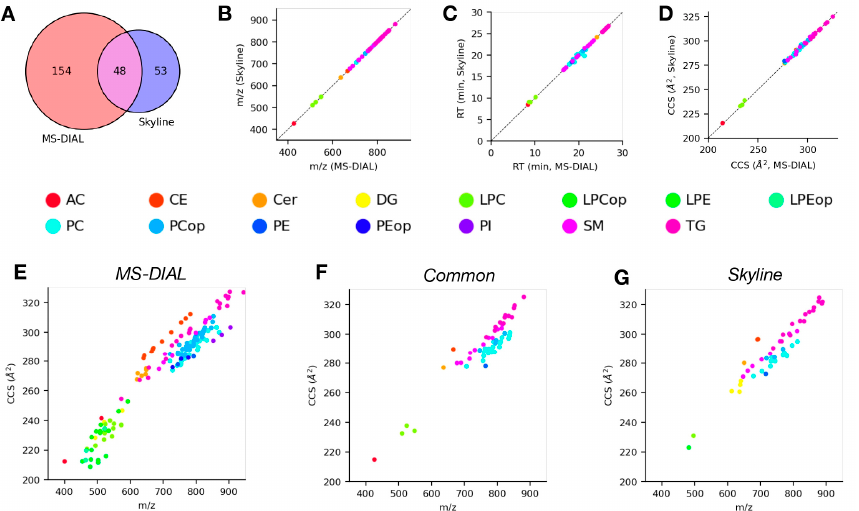
Figure 4. Comparison of lipid identifications from analysis of positive mode LC-TIMS-MS/MS lipidomics data using Skyline and MS-DIAL. ( A ) Venn diagram of lipids identified using either software. ( B – D ) Comparisons of m / z ( B ), retention time ( C ), and CCS ( D ) values from MS-DIAL vs. Skyline for common lipid identifications from both tools, points colored according to lipid class. ( E , F ) CCS trend lines or IMS-MS conformational space of lipids identified by MS-DIAL ( E ), Skyline ( G ), or both tools ( F ), points colored according to lipid class.